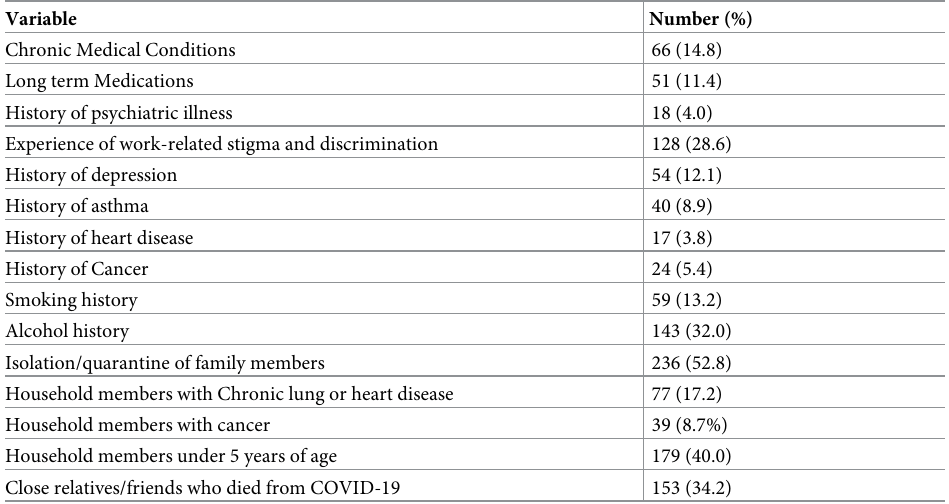
Table 2. Medical history and participants’ social circumstances (n = 447).